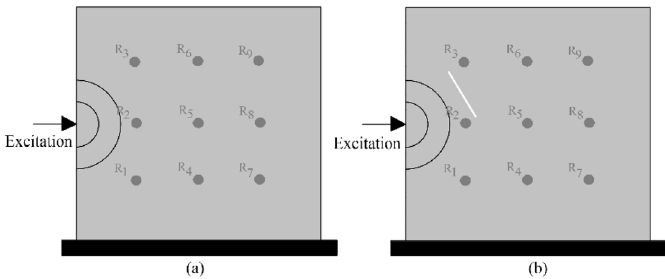
Figure 4. The boundary conditions and assigned reference points: ( a ) horizontal excitation without generated crack; ( b ) horizontal excitation with generated crack.